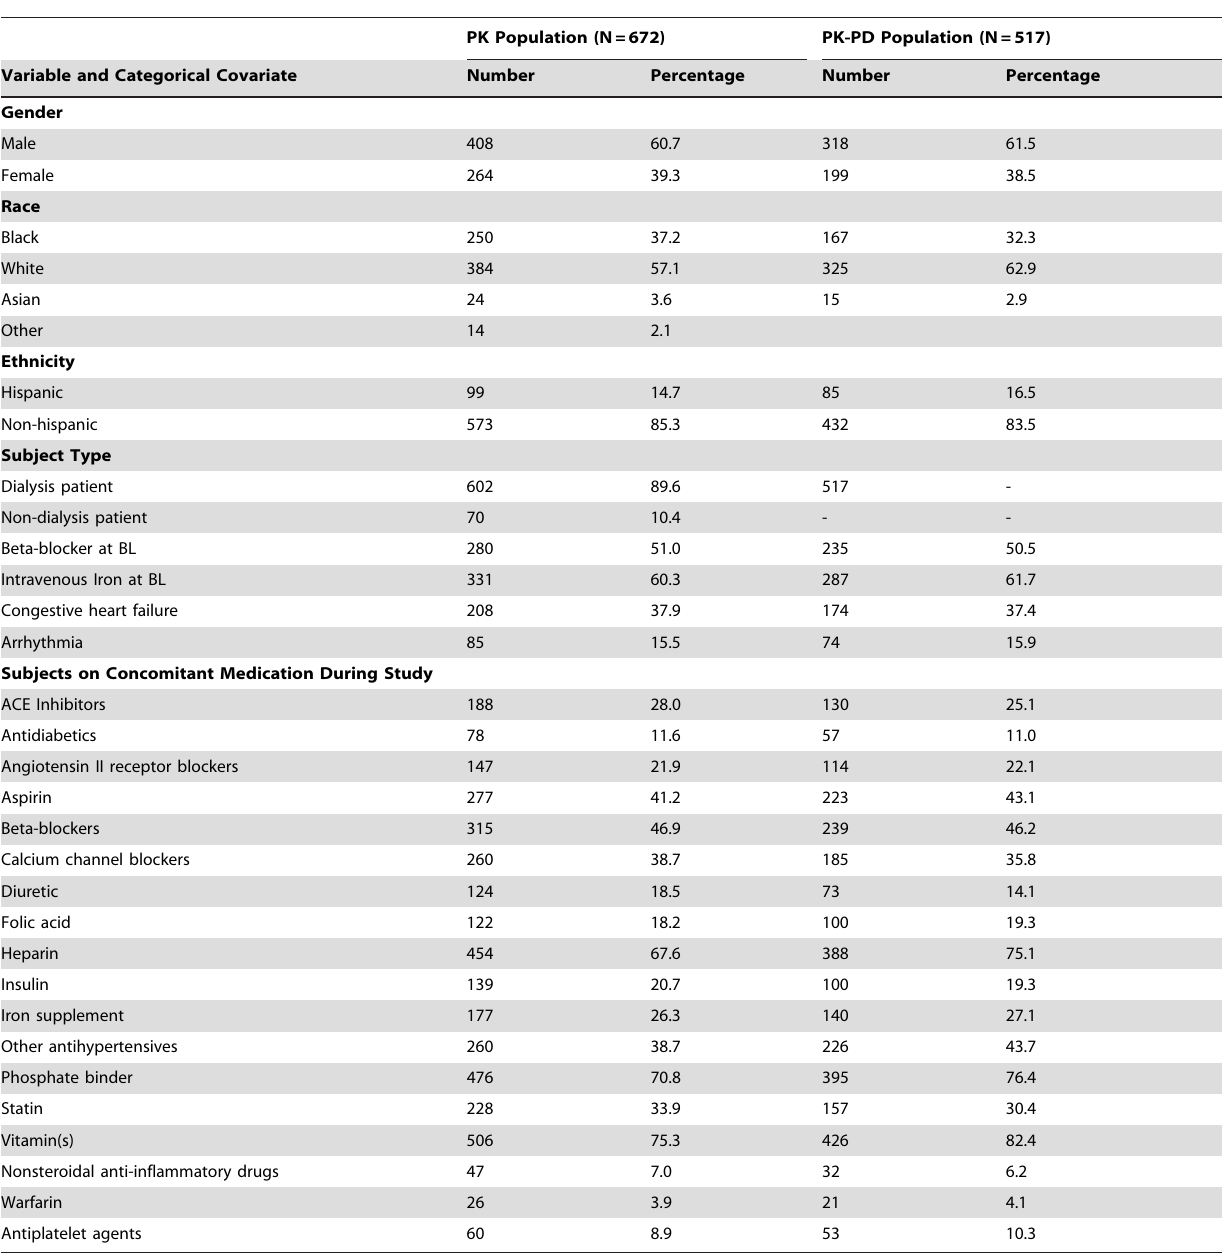
Table 2. Summary of categorical covariates and concomitant medications, by population group.